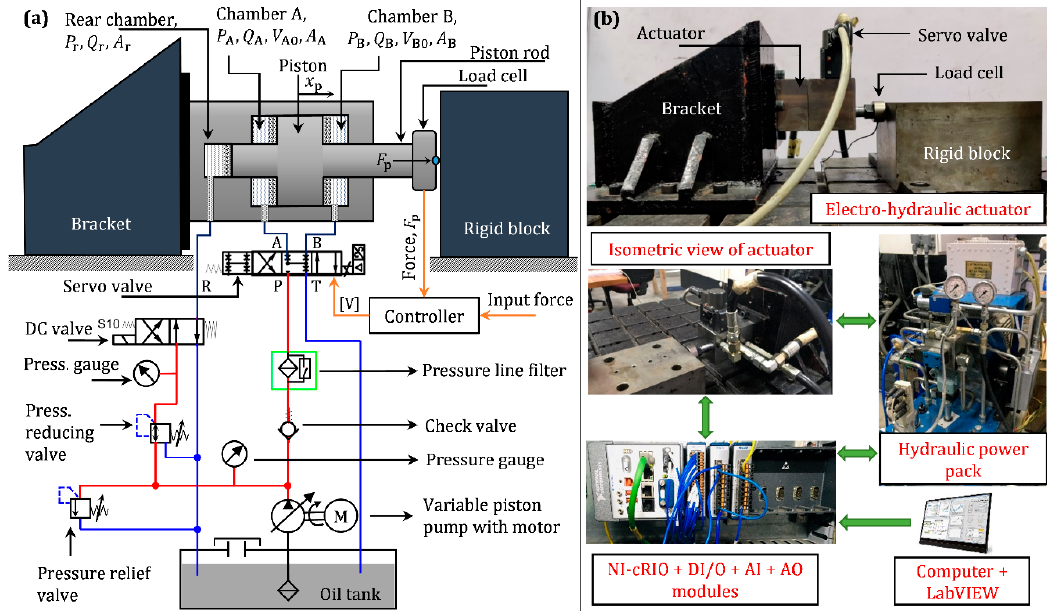
Figure 1. ( a ) Schematic of the electro-hydraulic actuator; ( b ) the experimental setup.